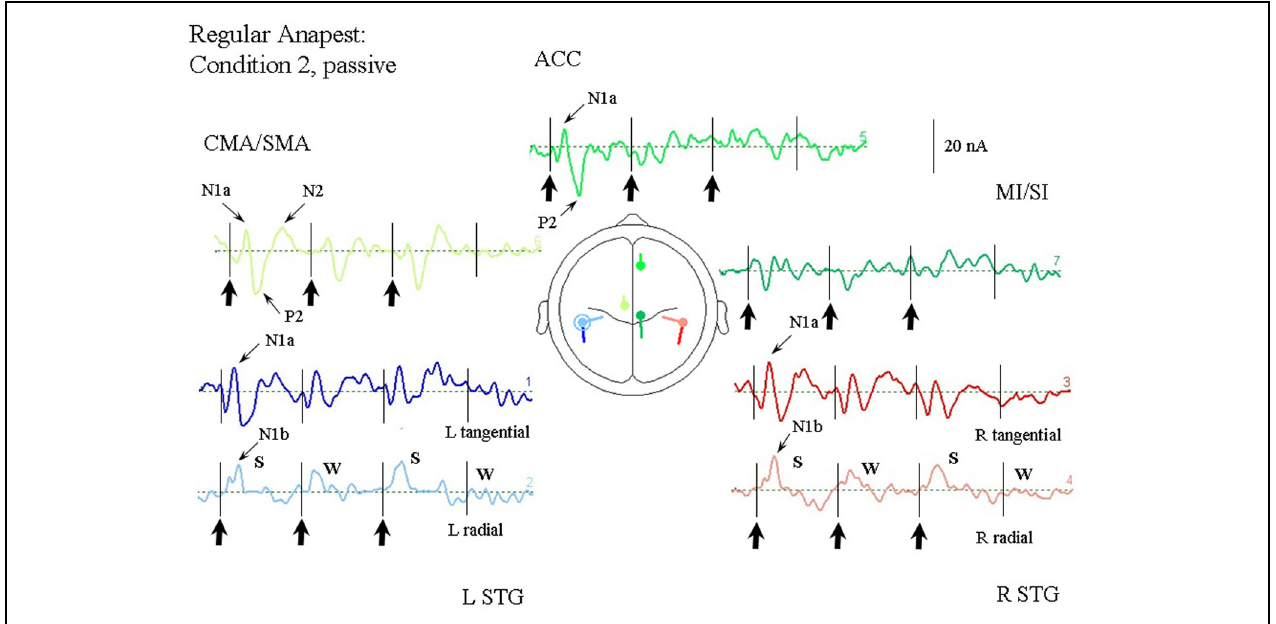
FIGURE 5 | Response of the optimum source model sources for passive listening to the regular anapest rhythm (condition 2), using the same arrangement as in Figure 4. Beat onsets are indicated by vertical bars and click stimulus onsets by bold arrows. Note the appearance of a “Strong-Weak-Strong-Weak” (S-W-S-W) metrical pattern in the radial N1b source.